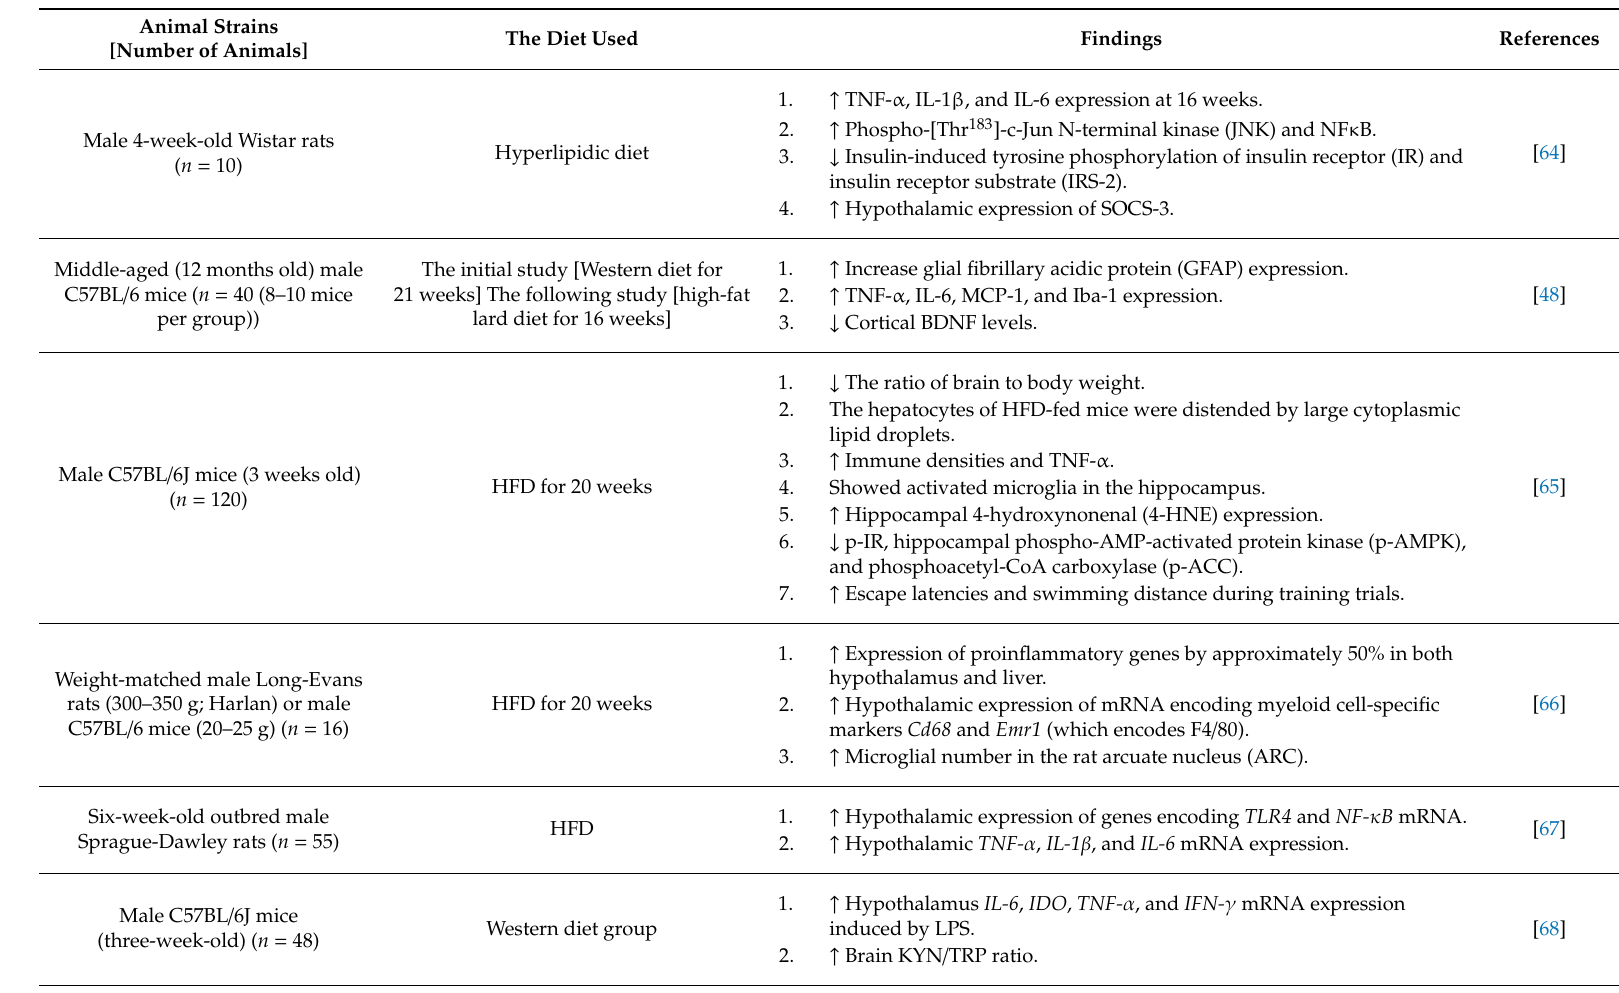
Table 1. The e ff ects of a HFD on cognitive function in animal